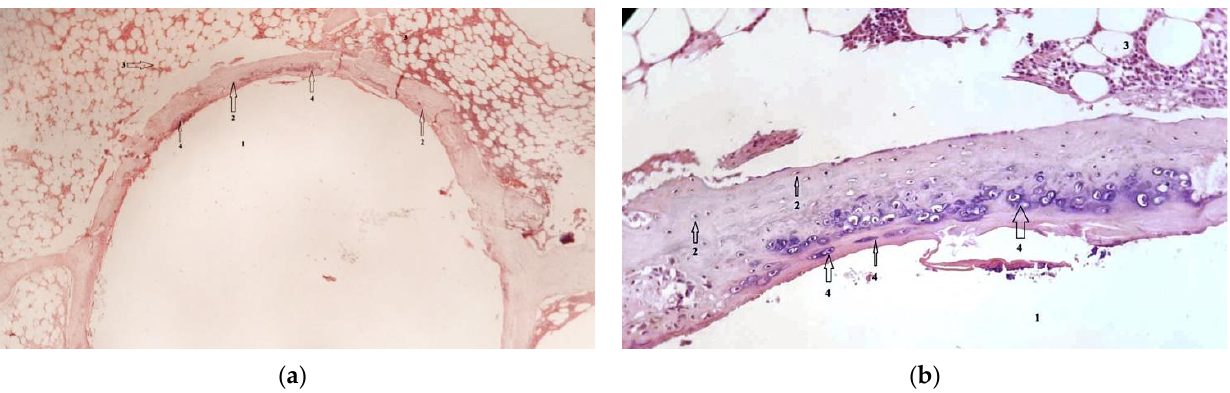
Figure 30. The overall aspect of the harvested bone, with the austenitic steel implant. 1-Centrally, the space left after the implant ablation. 2-A ring of bone tissue, dense, viable, with osteocytes visible in the form of discs and nuclei in their center. No remnants of alloy adherent to the bone surface are observed. At the level of the bone ring, near the implant bone interface, a chondroblastic proliferation is observed inside the bone tissue. 3-On the periphery the bone ring is surrounded by hematogenous marrow. 4-Viable basophilic cells, with a nucleus inside. These basophilic cells are identified as chondroblasts. ( a ) 10 × 4 magnification with HE staining. ( b ) 10 × 20 magnification, HE stain-